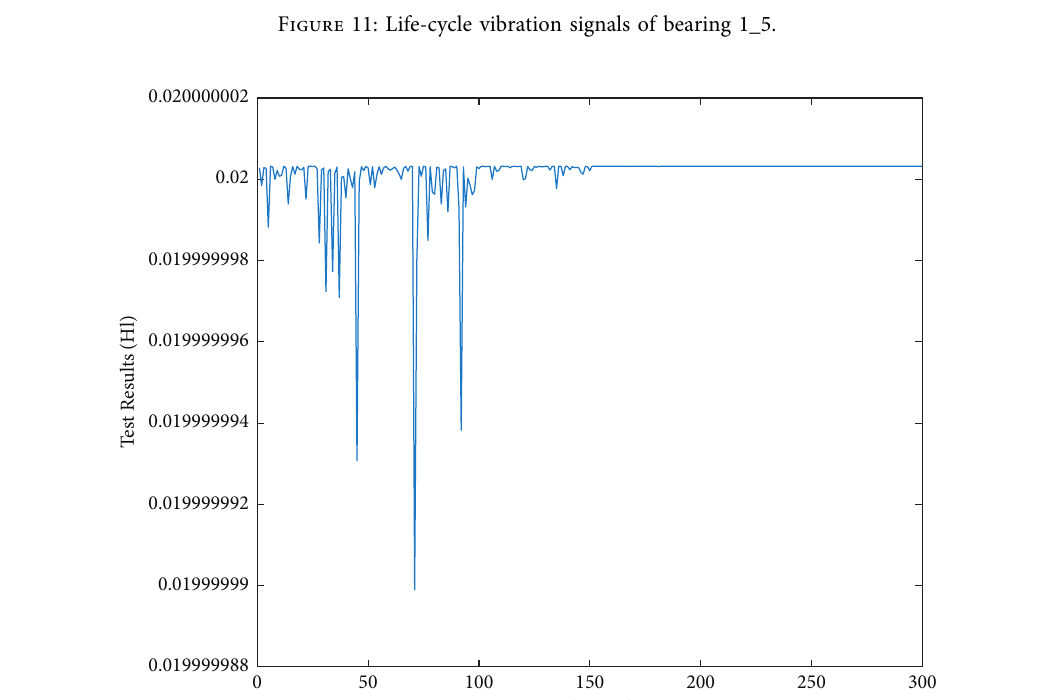
Figure 12: OWT evaluation chart without feature extraction.